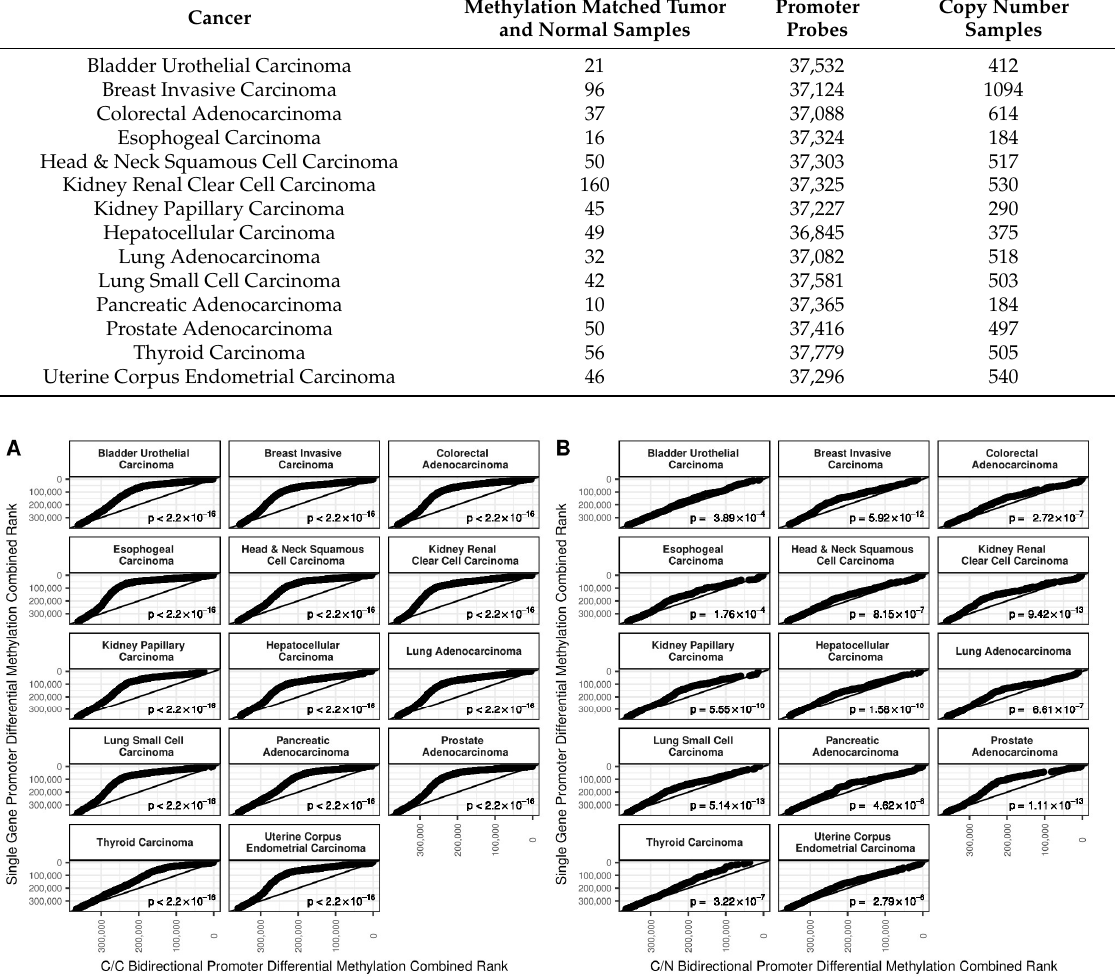
Figure 2. Quantile-quantile plots demonstrating degree of differential methylation in 17,639 single gene vs. 725 C/C ( A ) and 135 C/N ( B ) bidirectional promoters. At every quantile of rank differential methylation for bidirectional promoters, the rank of differential methylation for single gene promoters was always lower. This means that the single gene promoters were consistently more differentially methylated than bidirectional gene promoters for both bidirectional promoter types. For every cancer, these results were statistically significant.